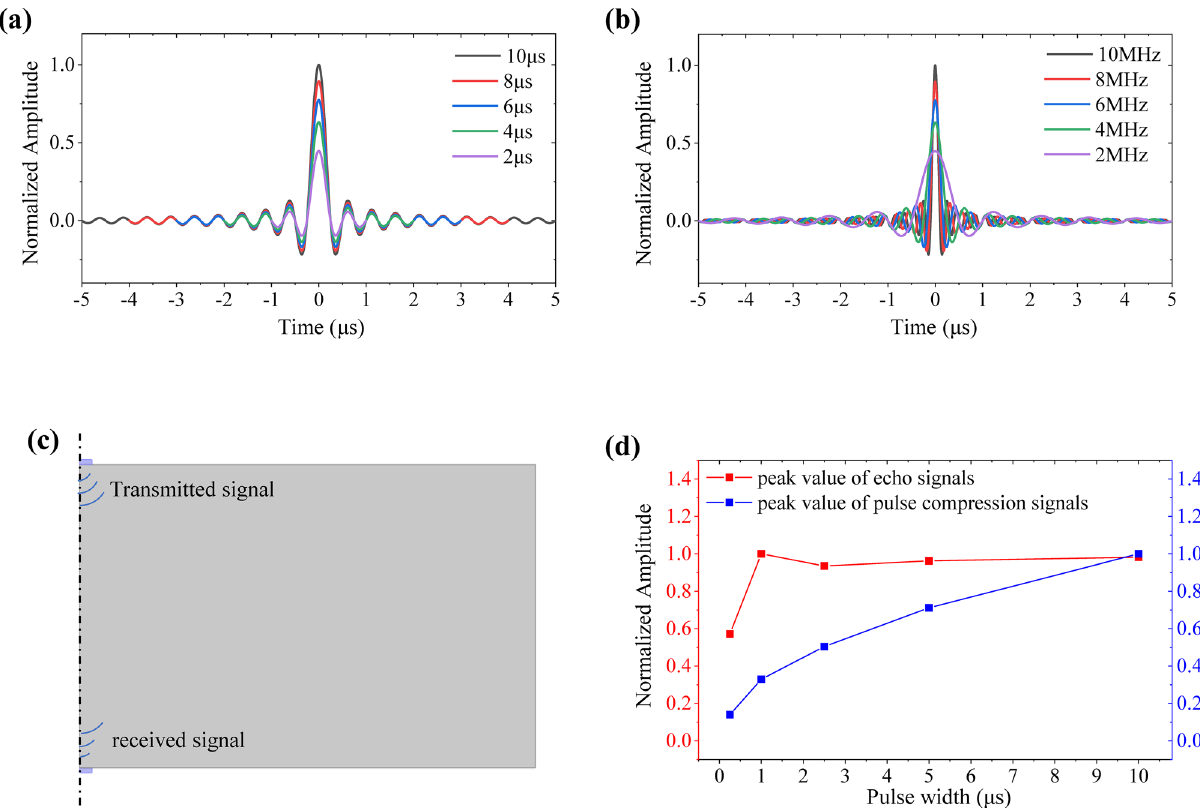
Figure 3. Parameter analysis of the LFM signal. ( a ) Pulse compression signals with different pulse widths of LFM signals ( B = 4 MHz). ( b ) Pulse compression signals with different bandwidth of LFM signals ( T = 10 μs). ( c ) The finite element model for transmission and reception of the LFM signals. ( d ) Normalized peak values of the echo signals and pulse compression signals with different pulse widths in example, when the pulse width T , the central frequency f 0 , and the bandwidth B are chosed as 10 μs, 5 MHz, and 4 MHz respectively, the time domain waveform, the instantaneous frequency (Fig. 2b), the amplitude-frequency characteristic curve of the LFM signal (Fig. 2c), and the time domain waveform of the pulse compression signal (Fig. 2d) are obtained from the above theoretical equations. In the bottom part of Fig. 2d, it is assumed that the time coordinate corresponding to first lobe value is t flv and the t flv satisfies the equation π Bt flv because of the Sa function in Eq. (16). Then the first lobe value is obtained as